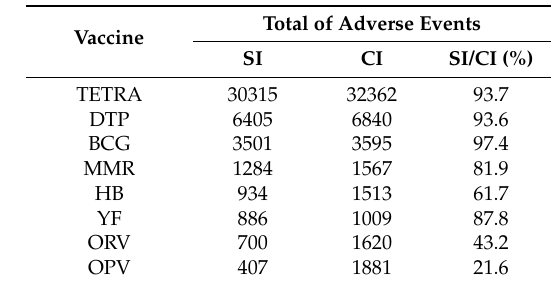
Table 1. Total of adverse postvaccination events considering single inoculation (SI) and combined inoculation (CI) with other vaccines in the same visit.